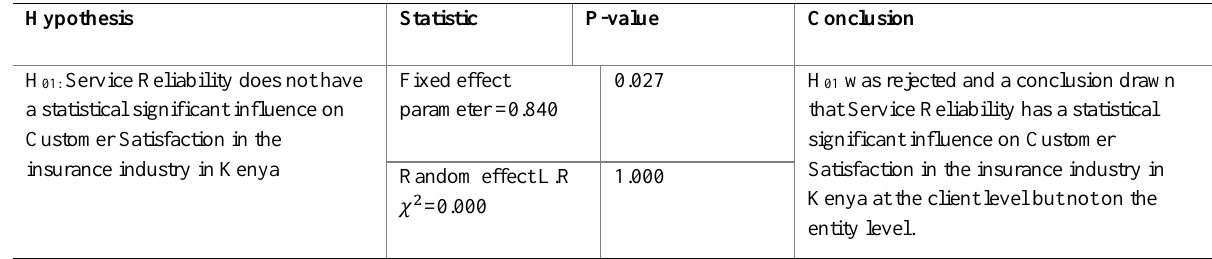
Table 5: Summary of Hypotheses